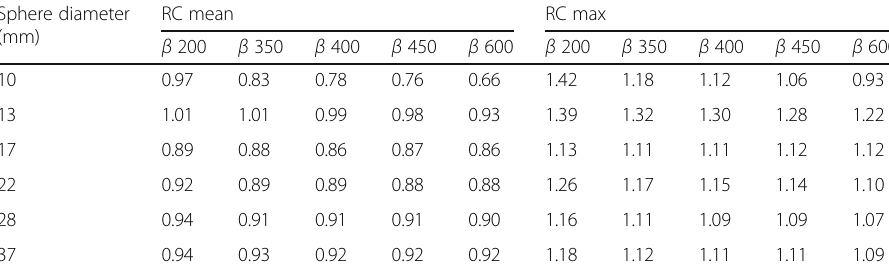
Table 2 Optimization of Q.Clear β penalization factor Sphere diameter